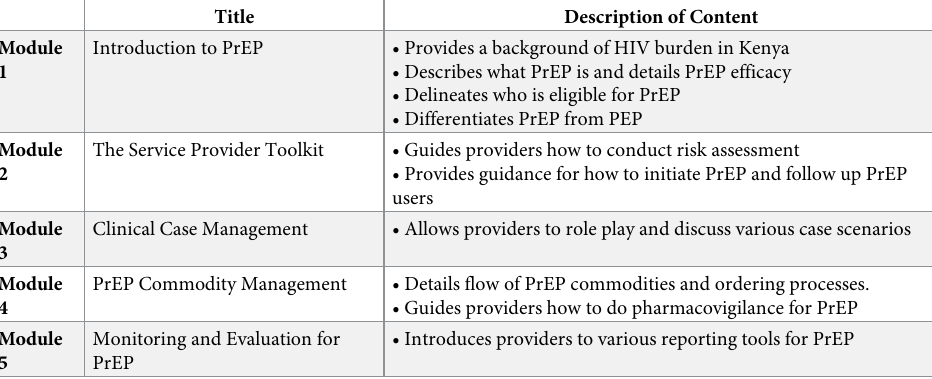
Table 1. Modular structure of the PrEP